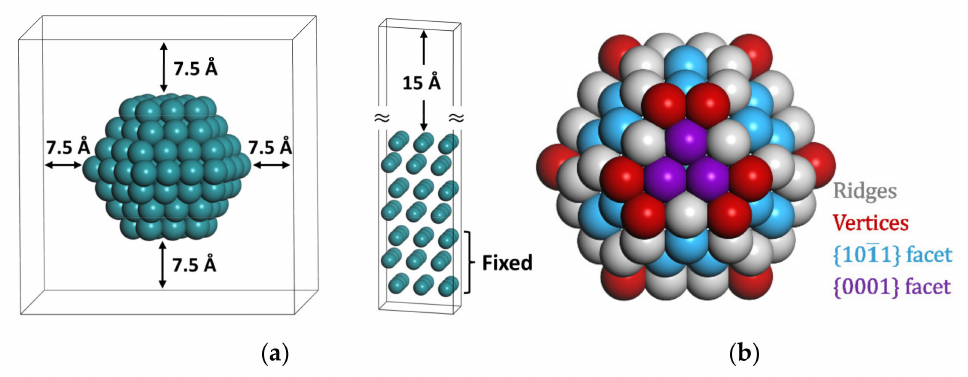
Figure 4. ( a ) Models of the Ru 153 nanoparticle and Ru(0001) and ( b ) distribution of Ru atoms at facets, ridges, and